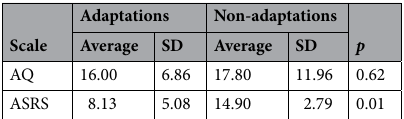
Table 5. Examination for a difference in average value of AQ and ASRS.